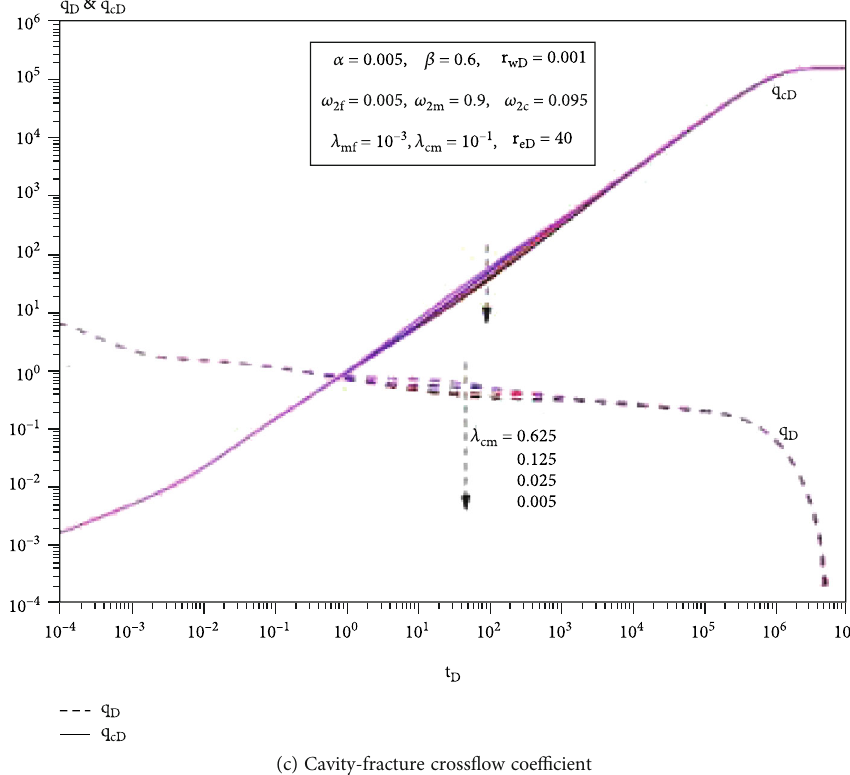
Figure 9: In fl uence of cross fl ow coe ffi cients of triple media on the production of an AFVW in a pore-cavity-fracture carbonate reservoir.